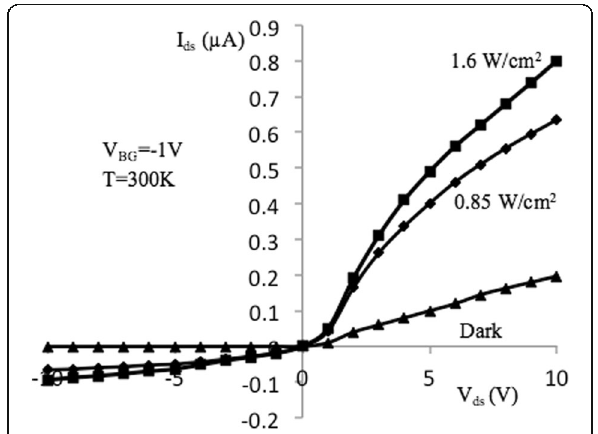
Fig. 3 I – V characteristics of NW FET, measured at optical excitation ( V BG = − 1 V). Output current – voltage characteristics of NW FET sample with length l = 10 μ m, measured in the dark and at excitation by the light specific power 0.85 and 1.6 W/ cm 2 , at T = 300 K and V BG = − 1